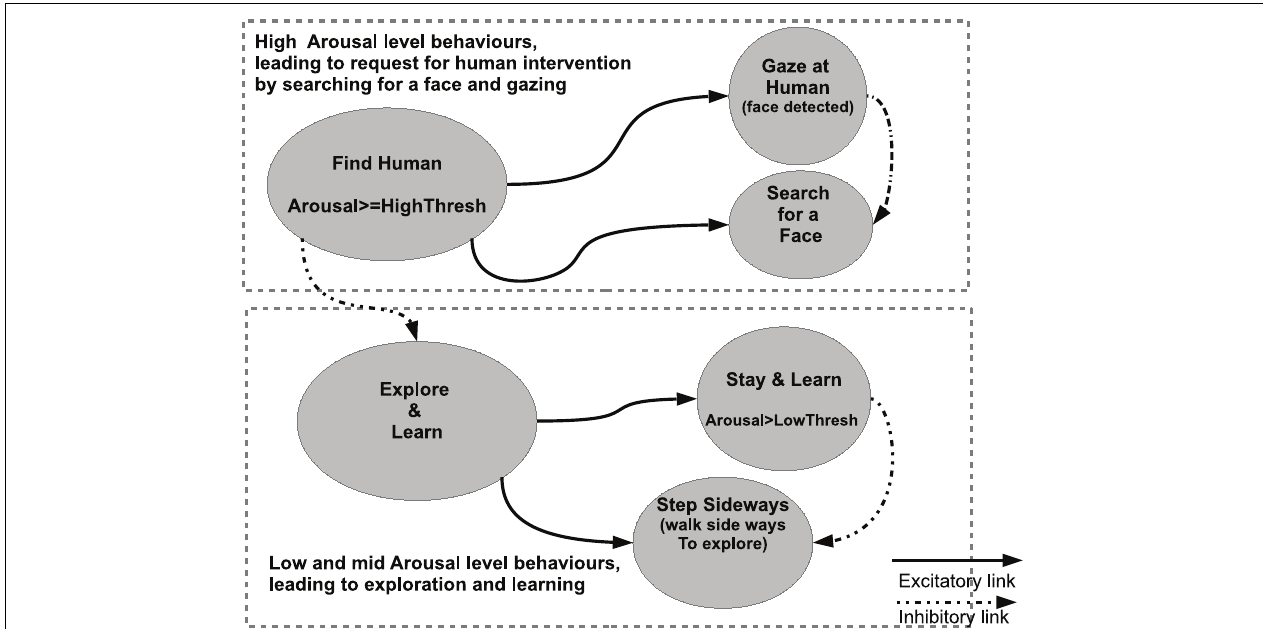
FIGURE 4 | Behaviors used and their connectivity. The two behavioral systems “Explore-and-learn” (exploratory behavior) or the “Find-Human” (the main regulatory behavior) are mutually inhibiting. If the Arousal level is above than Highthresh , the regulatory behavior is activated and in turn inhibits the exploratory behavior. The “Explore-and-learn” behavior, when active, activates the two connected behaviors “Stay-and-Learn” and “Step-Sideways.” The activation of the behavior “Stay-and-Learn” is modulated by the Arousal level. If the Arousal level is above LowThresh , the